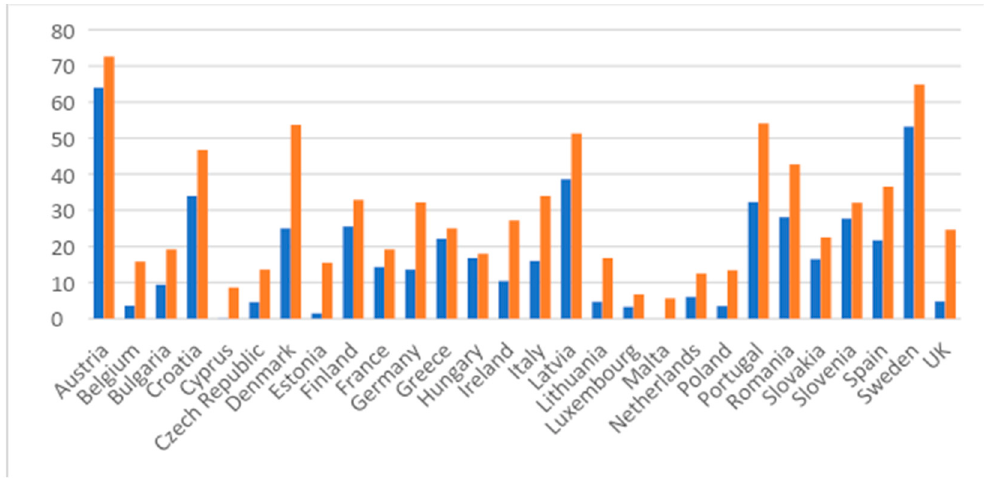
Figure 1. Share of renewable energy in electricity in 2007 and 2017 in the EU-28 countries (blue—2007, orange—2017). Source: own results.